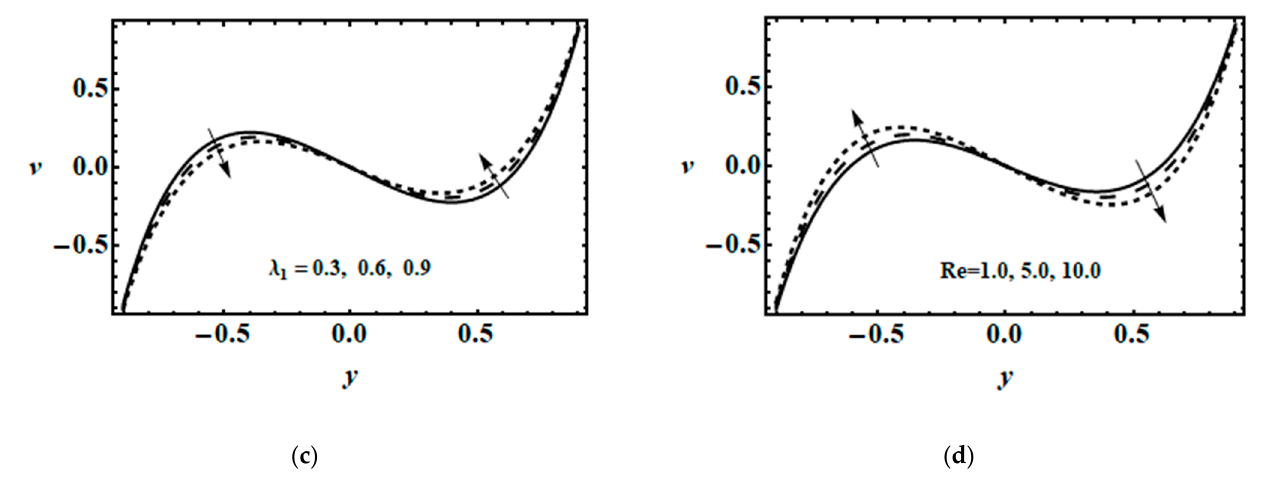
Figure 3. Influence of ( a ) M ( λ 1 = 1, K = 0.1, Re = 0.1), ( b ) K ( λ 1 = 1, M = 1, Re = 0.1), ( c ) λ 1 ( M = 1, K = 0.1, Re = 0.1) and ( d ) Re ( λ 1 = 1, M = 1, K = 0.1) on the vertical velocity v for α = 0.4, β = 0.4, ε = 0.1, Q = 1.5.